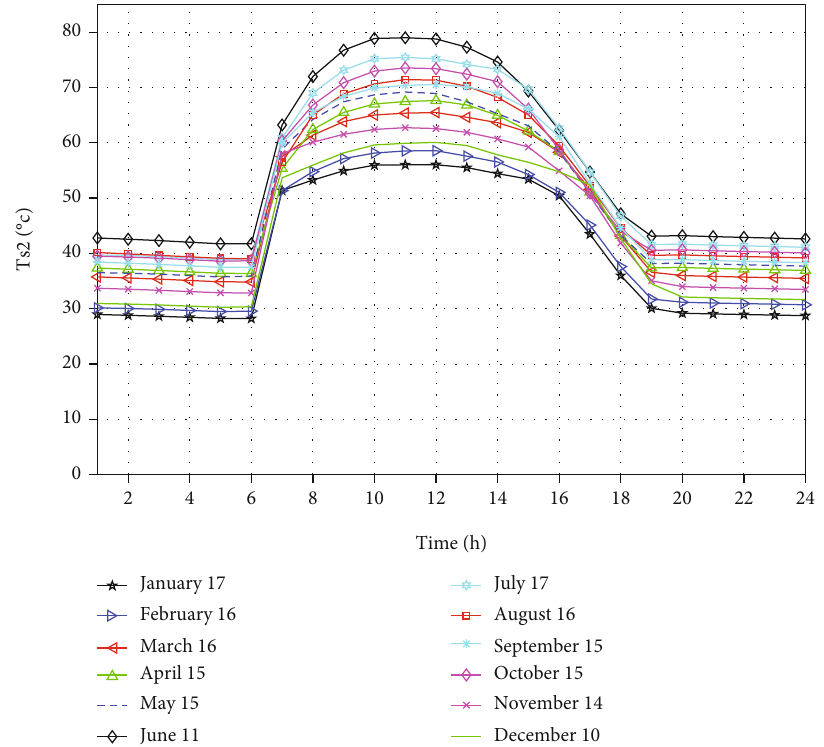
Figure 9: Storage water temperature for motel consumption pattern